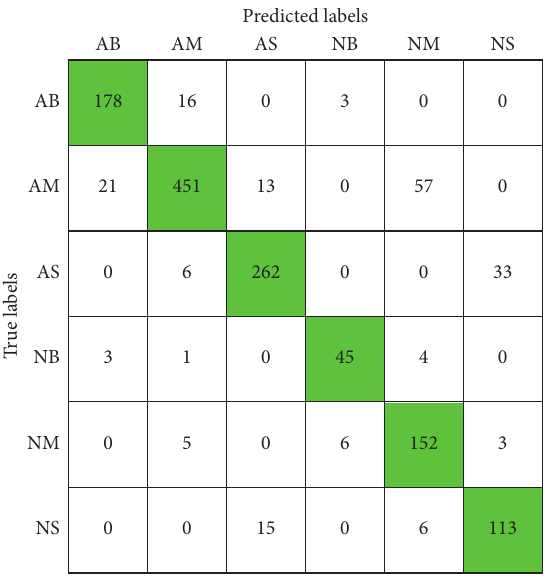
Figure 9: Confusion matrix of the CNN